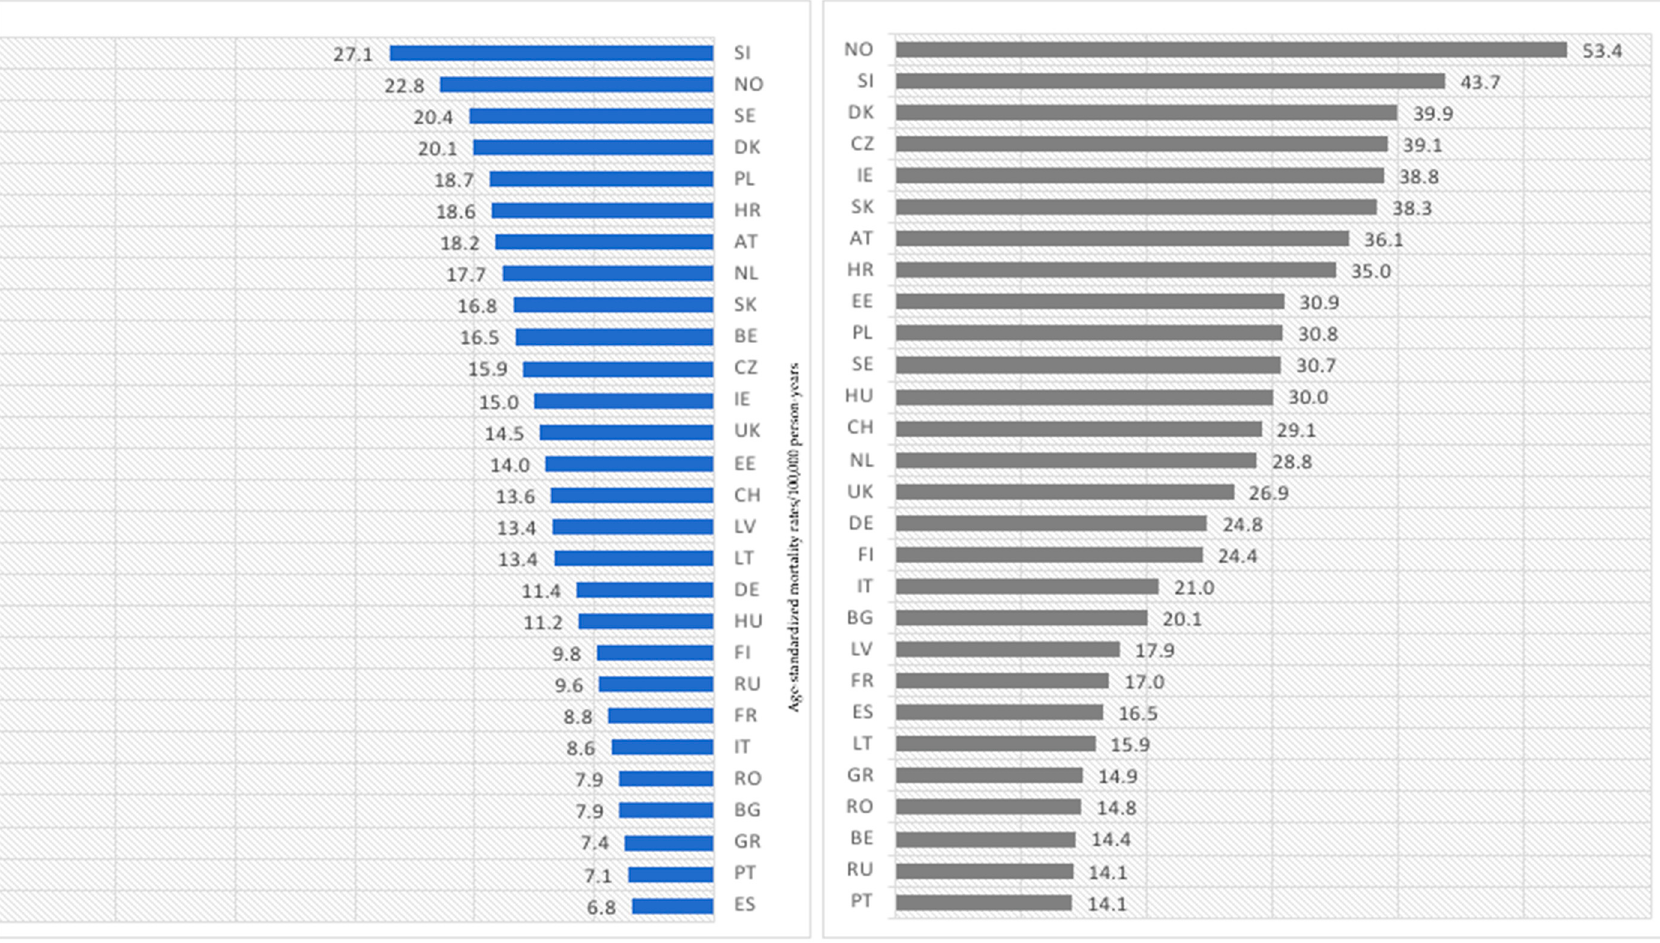
Figure 8. Age-standardized melanoma-mortality rates in women and men aged 75+ years old in 2020 or the last available year (2018 or 2019) in 28 European countries ( SI—Slovenia; NO—Norway; SE—Sweden; DK—Denmark; PL—Poland; HR—Croatia; AT—Austria; NL—the Netherlands; SK—Slovakia; BE—Belgium; CZ—